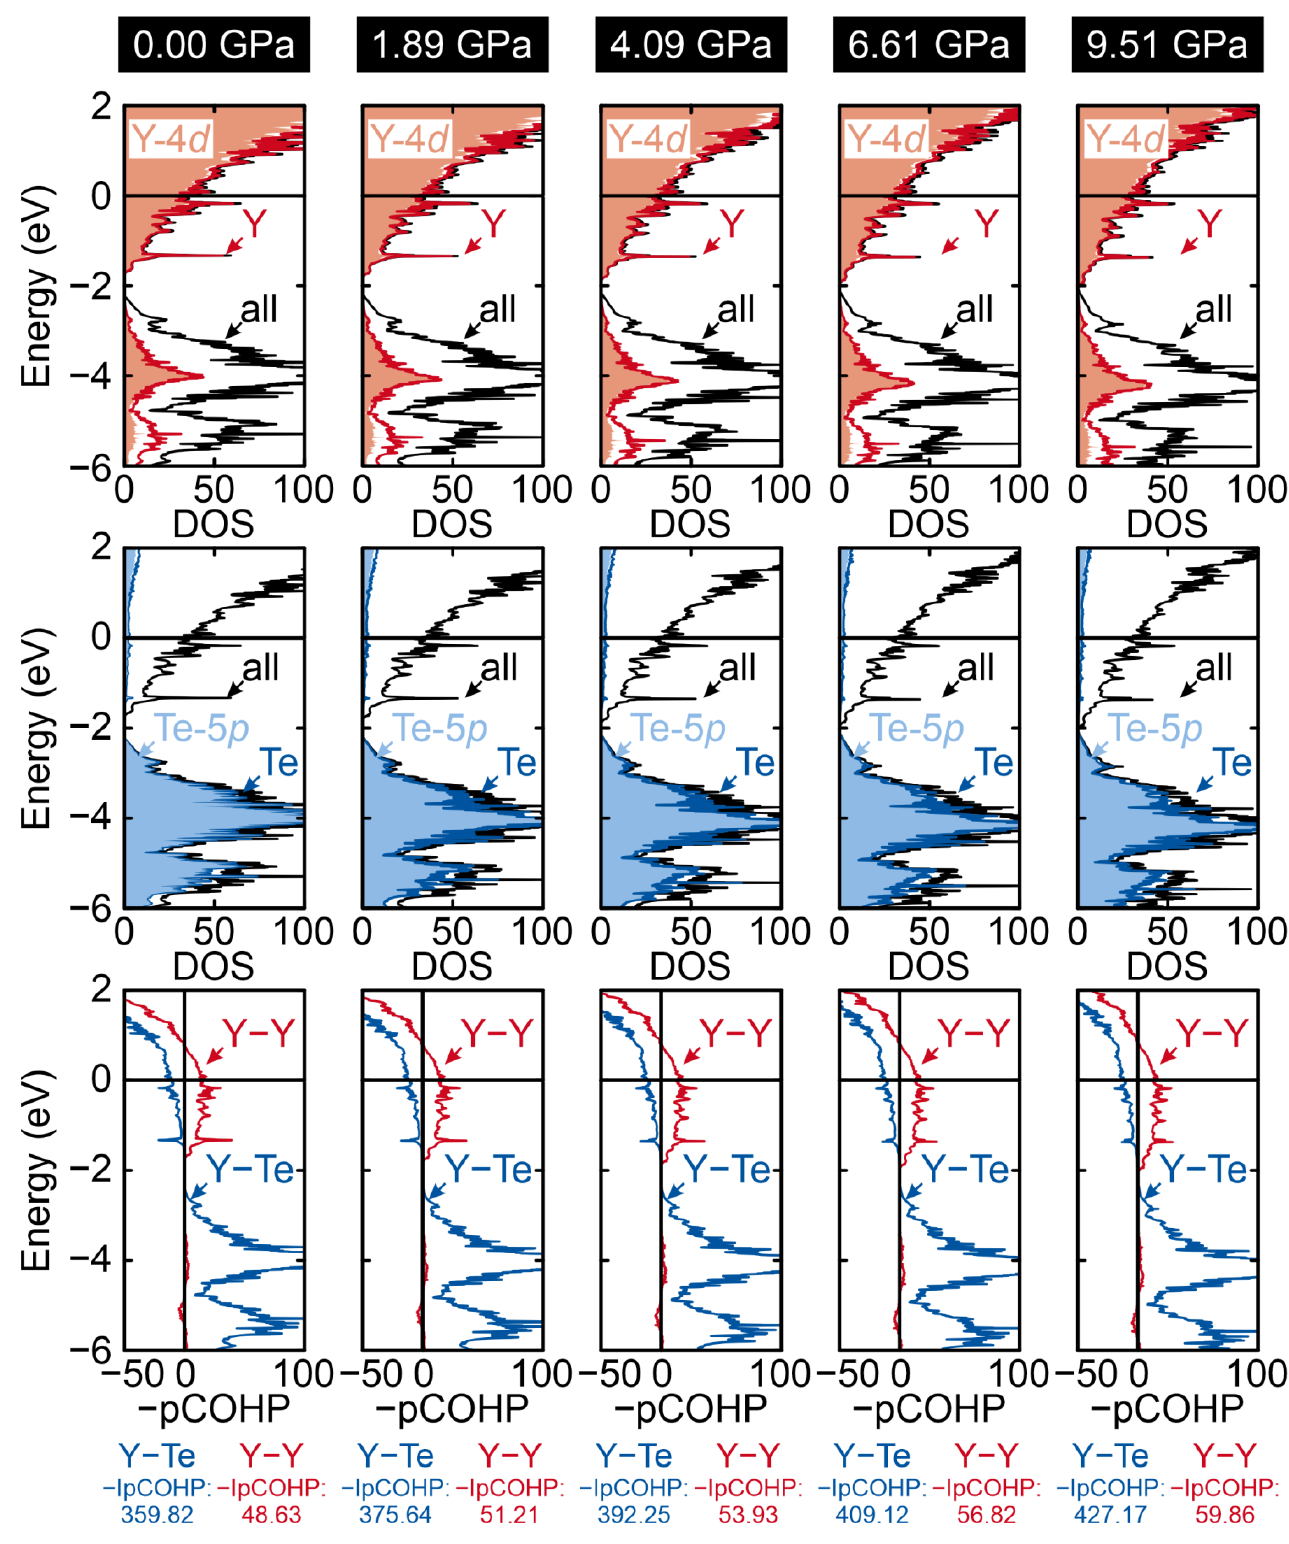
Figure 5. Pressure-dependent density-of-states (DOS) curves and projected crystal orbital Hamilton populations ( – pCOHP) of the tellurium-deficient Y 32 Te 31 . The Fermi levels, E F , are denoted by the black horizontal lines, while the cumulative – IpCOHP/cell values (see main text) are included below the respective – pCOHP diagrams.